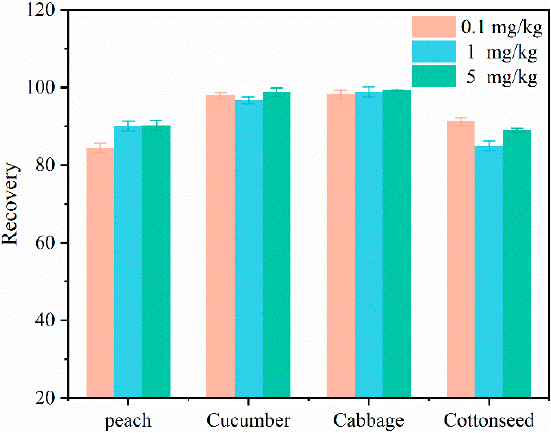
Figure 2. Recoveries of flonicamid in multiple matrices.